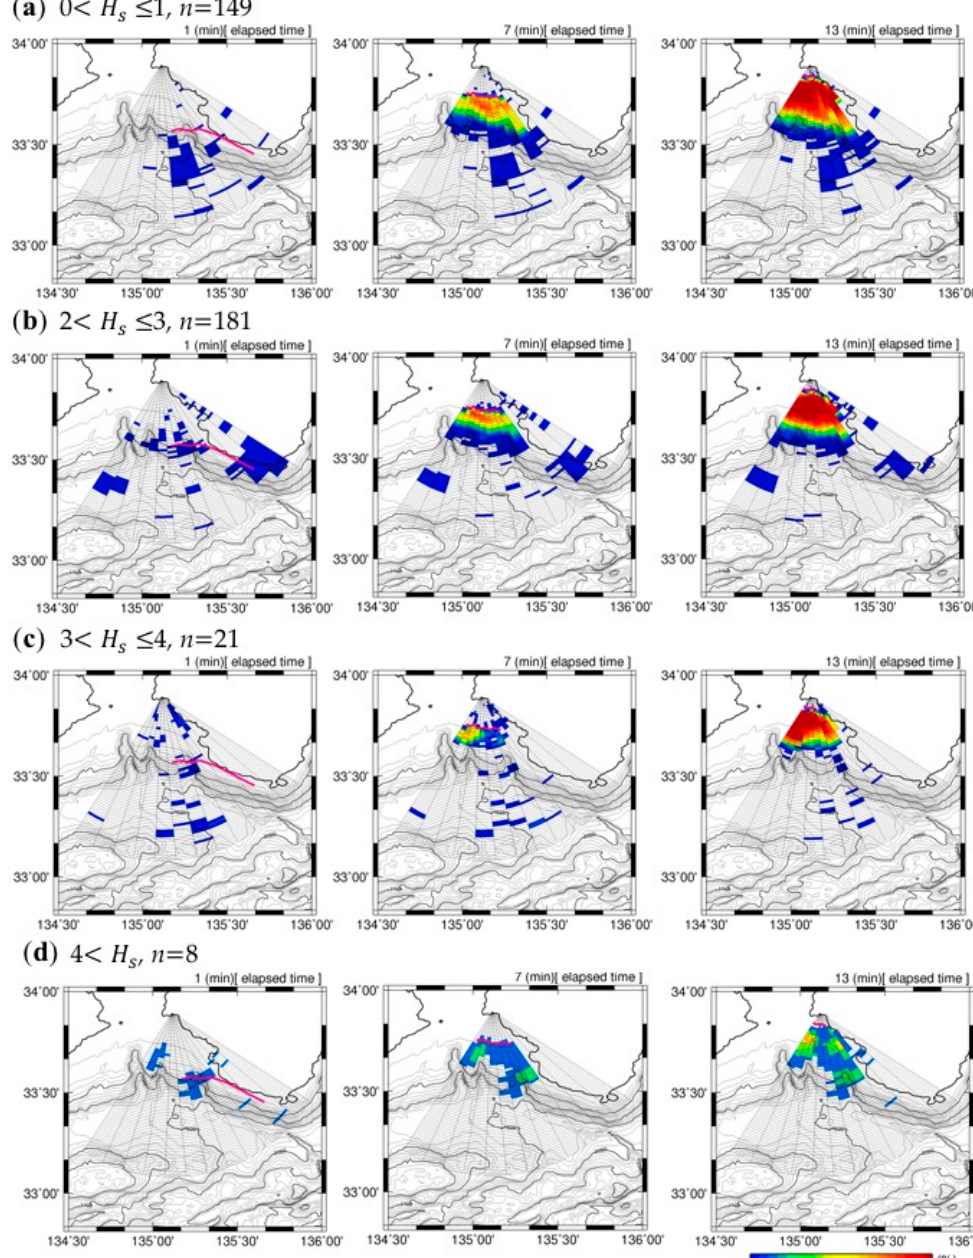
Figure 11. Temporal evolution of the detection probability at 1, 7, and 13 min after tsunami occurrence in different significant wave height ( H s ) conditions: ( a ) 0 < H s ≤ 1, ( b ) 2 < H s ≤ 3, ( c ) 3 < H s ≤ 4, and ( d ) 4 < H s . The background color represents the detection probability, and the pink line represents the first leading wavefront of the tsunami, m f ( b , t ) . The wave height is in meters and n represents the number of scenarios used to calculate the